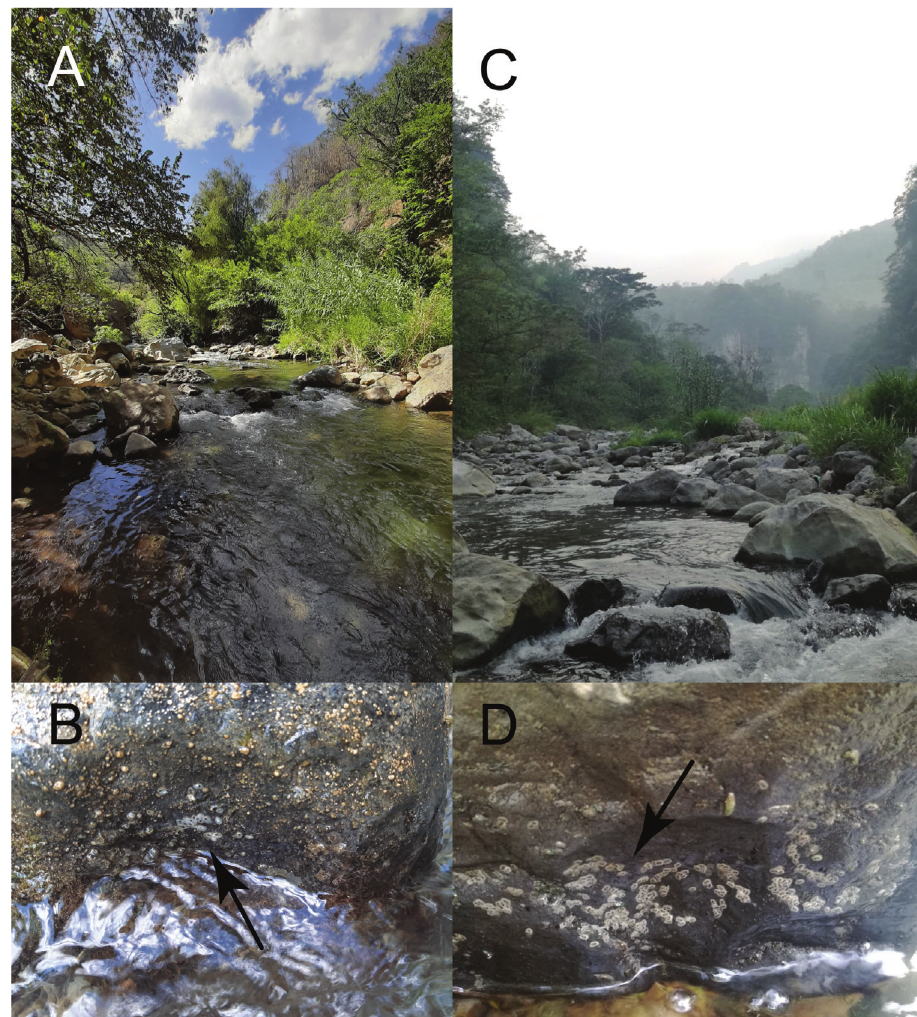
Figure 6. Collecting sites and cases of Mejicanotrichia in madicolous microenvironments A Tonalapa river, Guerrero B M. harrisi , pupal cases attached to rock, indicated by arrow C tributary of the Teapa river, Chiapas D M. tridentata , pupal cases attached to rock, indicated by